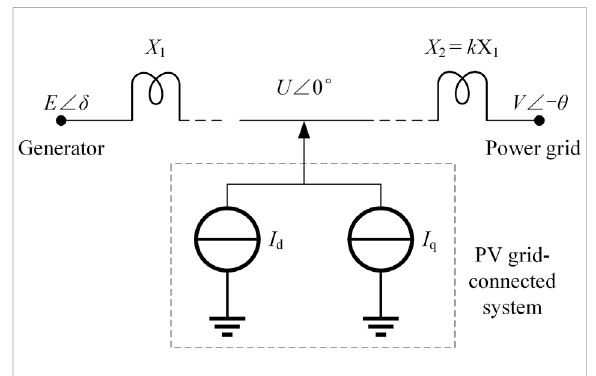
FIGURE 3 Equivalent model of a power grid with PV power generation.